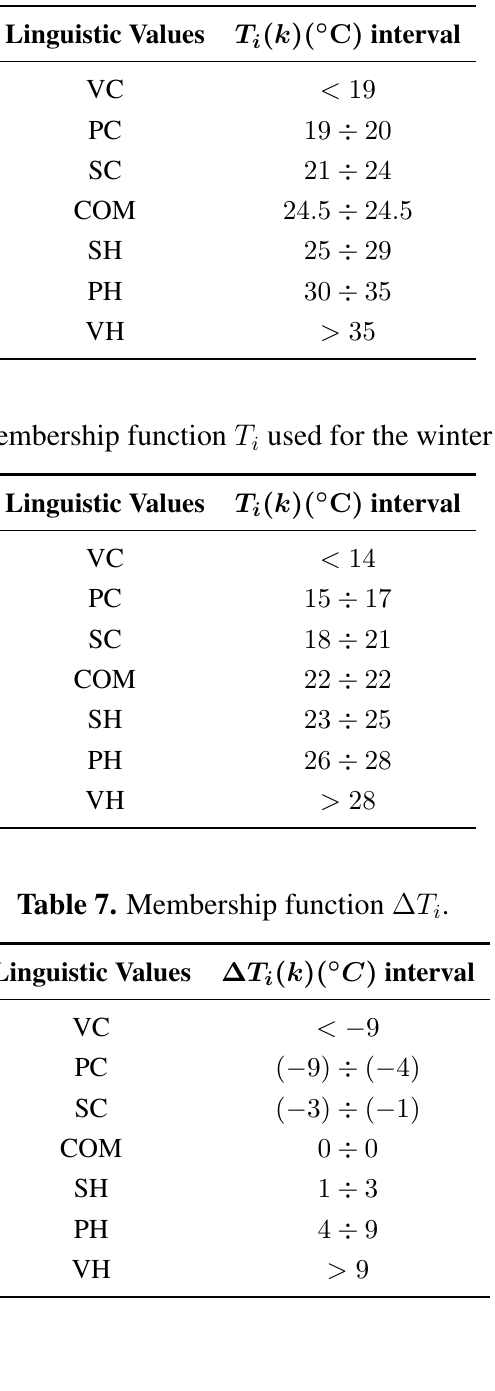
Table 5. Membership function T used for the summer scenario. VC, Very Cold; i PC, Pretty Cold; SC, Slightly Cold; COM, Comfortable; SH, Slightly Hot; PH, Pretty Hot; VH, Very Hot.